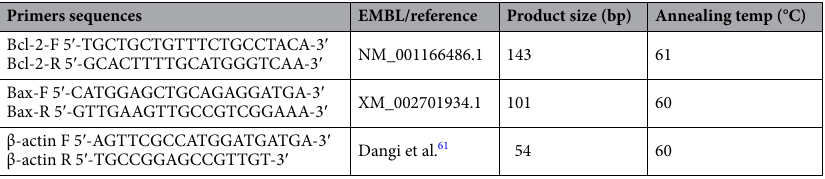
Table 1. Primers sequences of Bcl -2, Bax and β‑actin